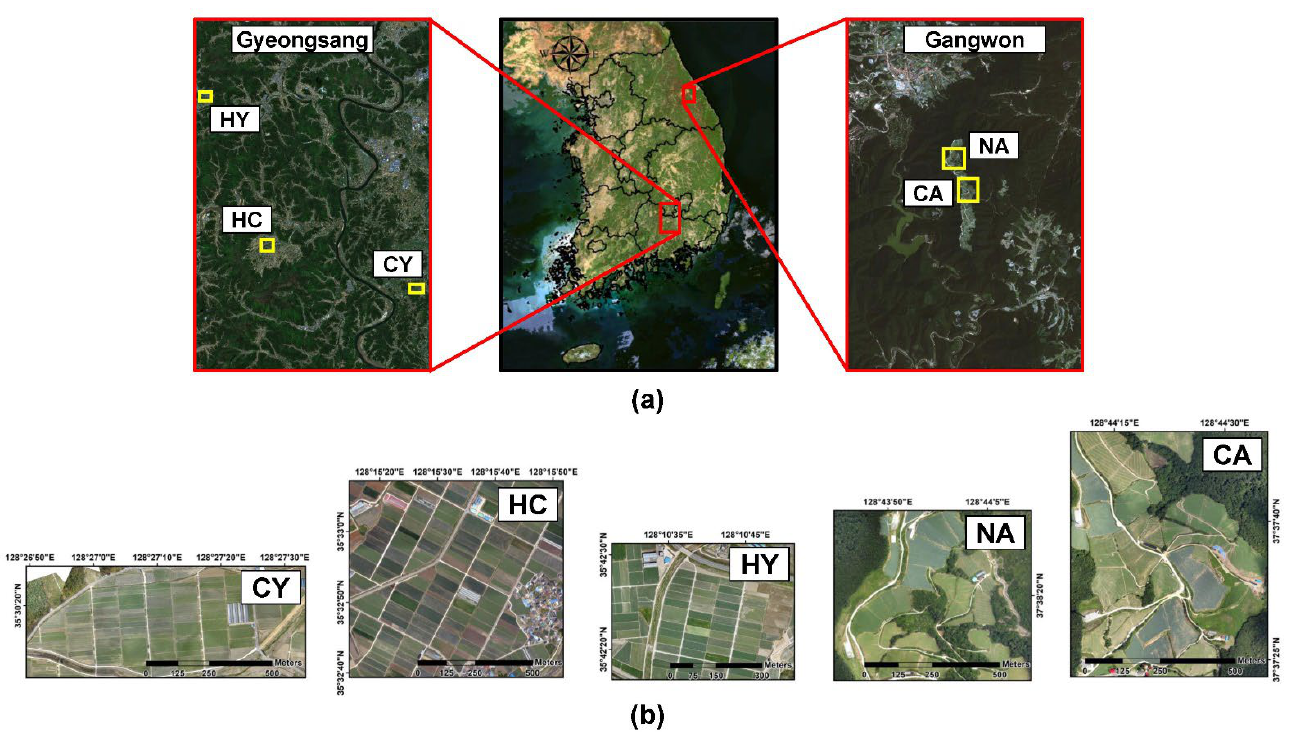
Figure 7. ( a ) Location of the two study areas; ( b ) UAV images zoomed in to a similar scale for each area.